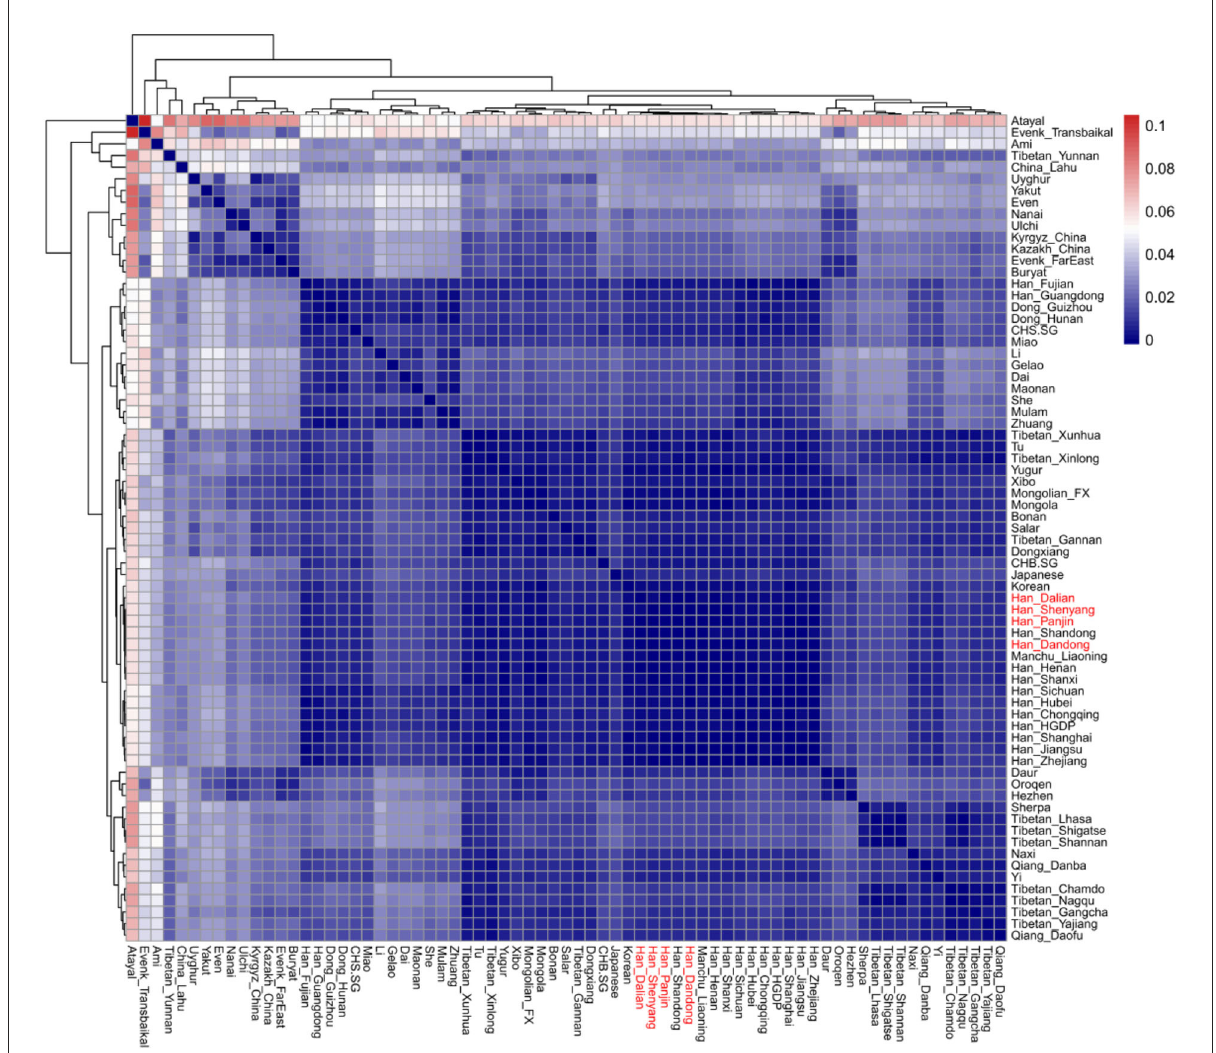
FIGURE3 Heatmap of genetic affinity among modern East Asian populations based on pairwise F ST genetic